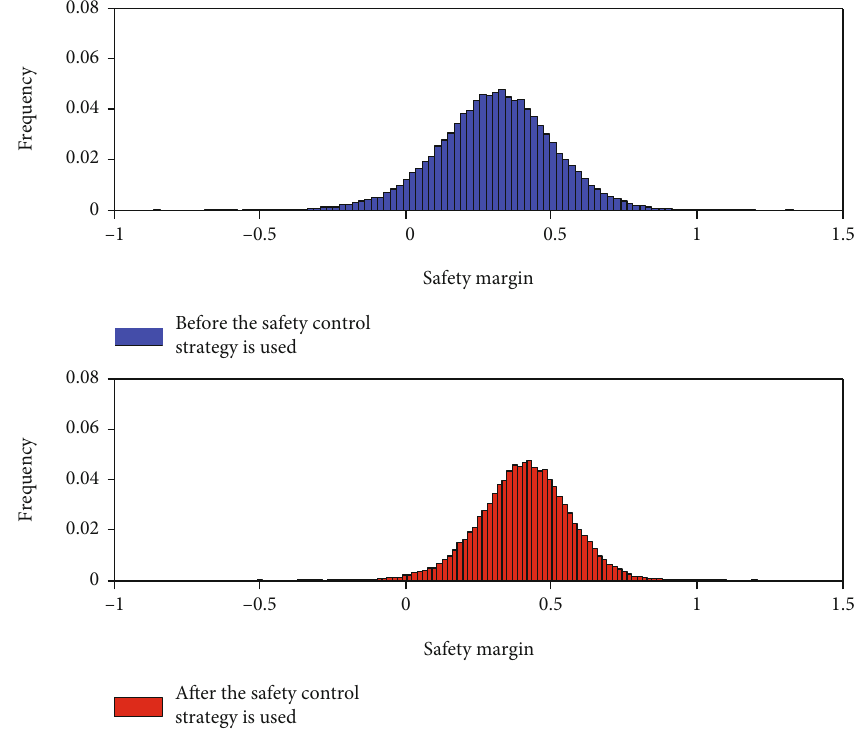
Figure 20: Probability distribution of the compressor surge margin Y